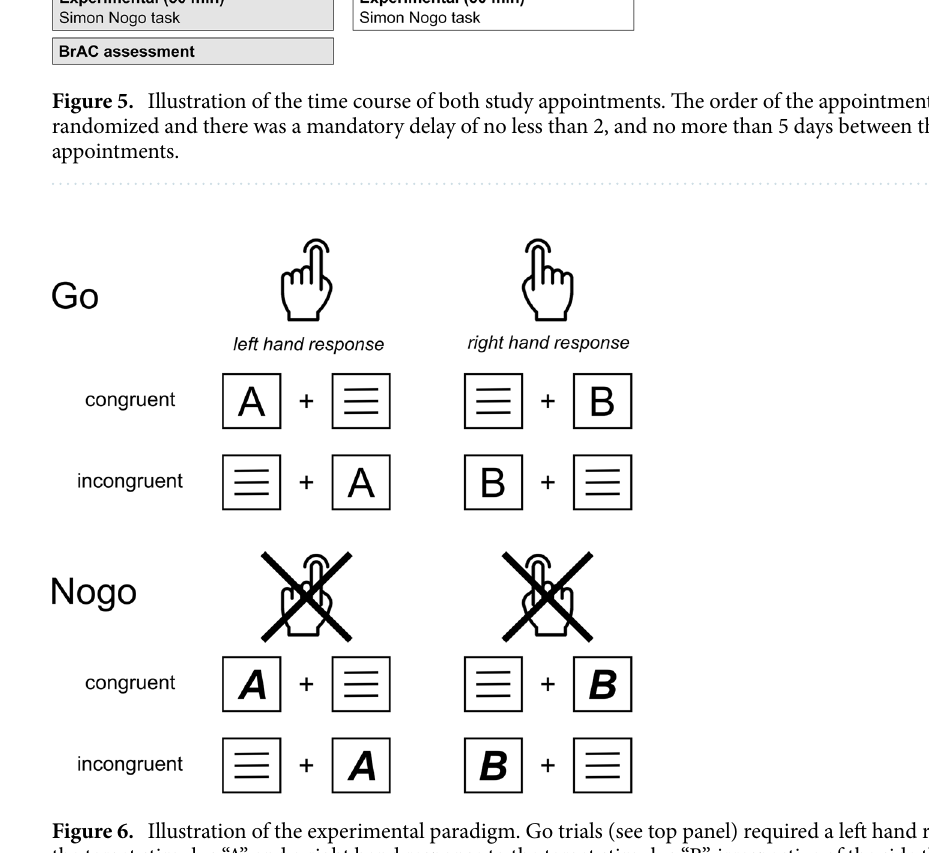
Each trial started with the 200 ms presentation of a lateralized target stimulus and a contralateral distractor and either ended with the first button press, or after 1200 ms, if no response was given. Stimulus "A" required a response on the left CRTL button while stimulus "B" required a response on the right CRTL button (Go trials). When the target stimulus was presented in a bold italic font (" A " or " B "), all reactions had to be inhibited (Nogo trials). When the spatial location of the stimulus matched that of the associated response hand (i.e., letter "A," on the left side of the screen or letter “B” on the rioght side of the screen), the trial was coded as congruent , while a mismatch between stimulus location and response hand was coded as incongruent . Go trials were presented at a ratio of 7:3 to Nogo trials, while congruent and incongruent trials were featured with the same frequency in both Go and Nogo trials. In total, 720 trials were presented in six equally sized blocks.